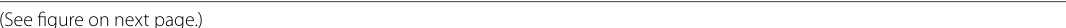
figure on next Fig. 4 Bias corrected forecasts of Gauss coefficients from differences between forecast sequences that start in 2016, 2017 and 2018. Each bias corrected forecast starts in the year of the later sequence. The solid line shows the 2020 forecast from the Goddard candidate model for IGRF-2020-SV, while the dashed (experiment A - experiment B), dash-dot (B-C) and dotted (A-C) lines show the bias corrected forecasts from our assimilation that use differences between the different forecast series. Panel a shows the coefficients for l = 1 and m = 1 , while panel b shows the coefficients for l = 2 , m = 1 . Each panel shows the the bias corrected forecasts for G m l (upper) and H m l (lower) from Eq.